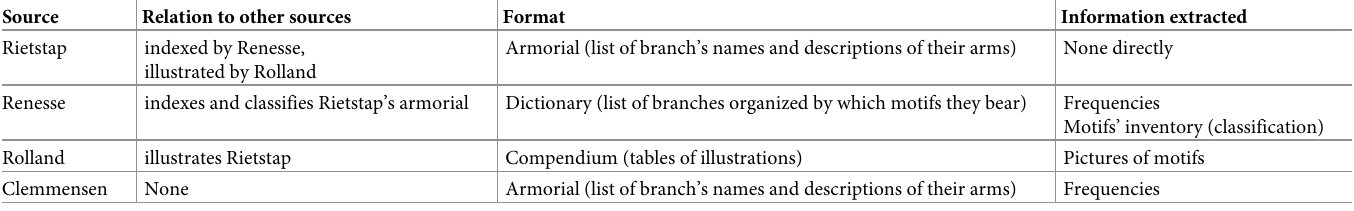
Table 1. Our sources, how they relate to each other, their format, and which information was used from each